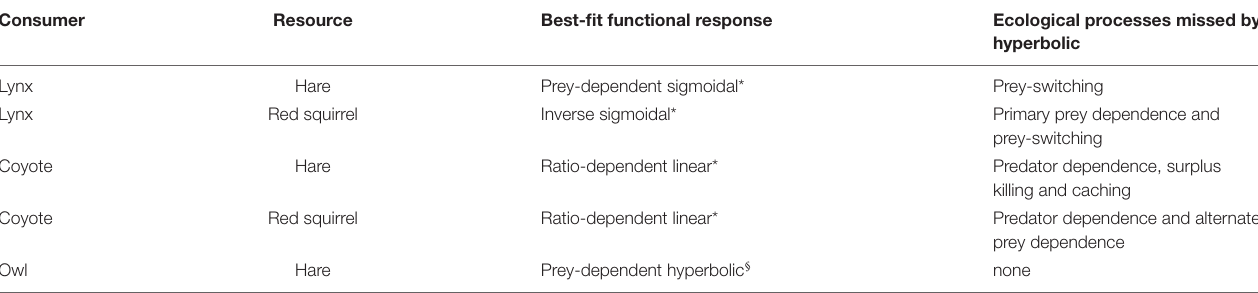
TABLE 1 | Best-fit functional response relationships for key predators and prey in the Kluane food web, and the ecological processes that are not accounted for when each is modeled using a prey-dependent hyperbolic functional response.